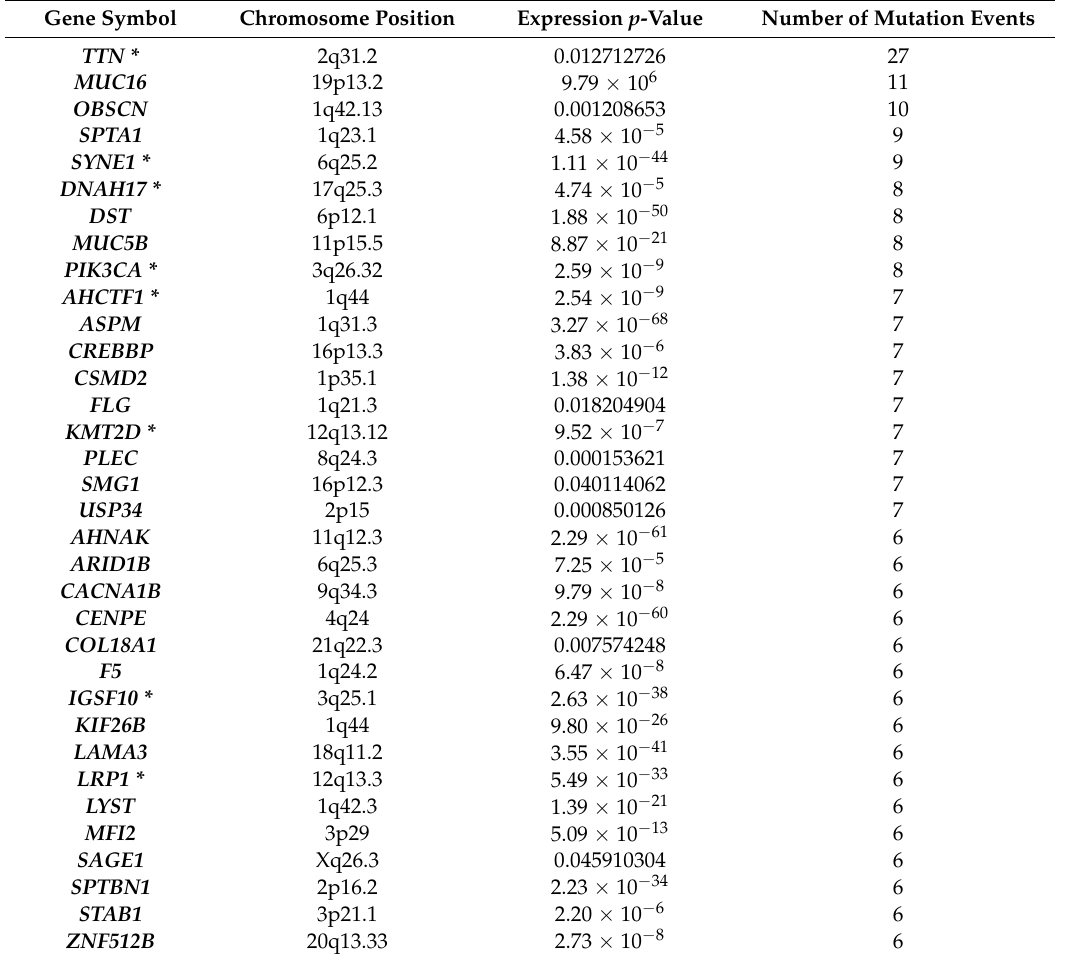
Table 1. List of the 34 gene signature containing the most highly somatic-mutated genes (>5 mutation events per gene) that were significantly differentially expressed between TNBC tumors and